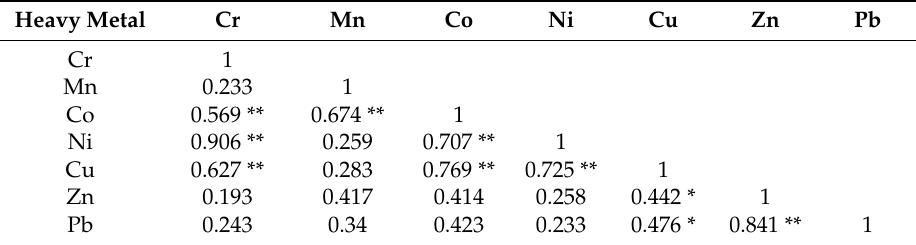
Table 4. Person’s correlation matrix of the heavy metals in the sediments from the Lishui River. Heavy Metal